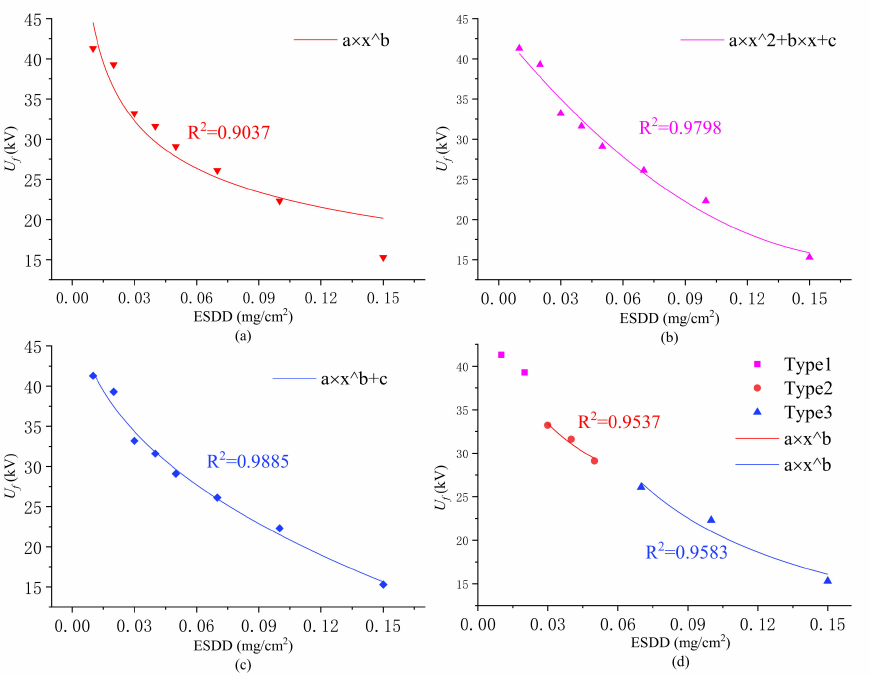
Figure 10. Fitting results of flashover voltage under different pollution degrees: ( a ) The fitting results using negative power function; ( b ) The fitting results using quadratic function; ( c ) The fitting results using negative power function with the constant term; ( d ) The fitting results using piecewise